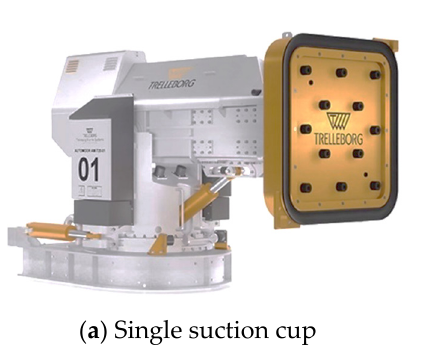
Figure 6. AutoMoor mooring systems of the Trelleborg company showing ( a ) Single suction cup, ( b ) Double suction cup (adapted with permission from Ref. [24]. Copyright 2022 Trelleborg).